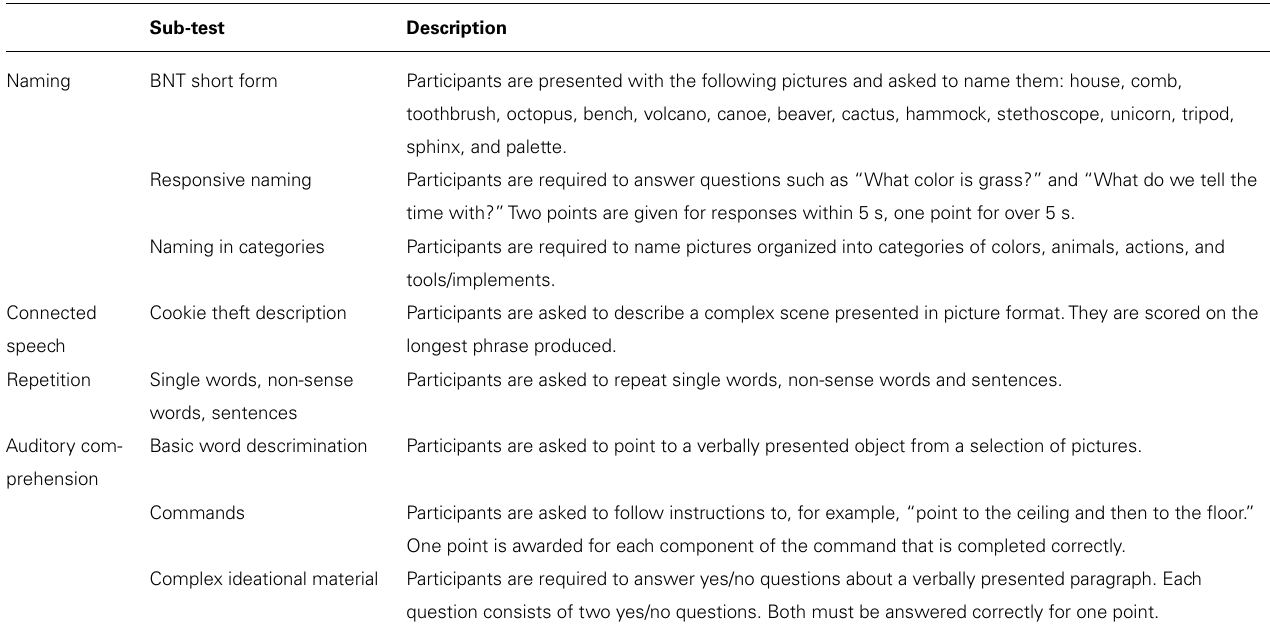
Table 1 | BDAE outcome measures.